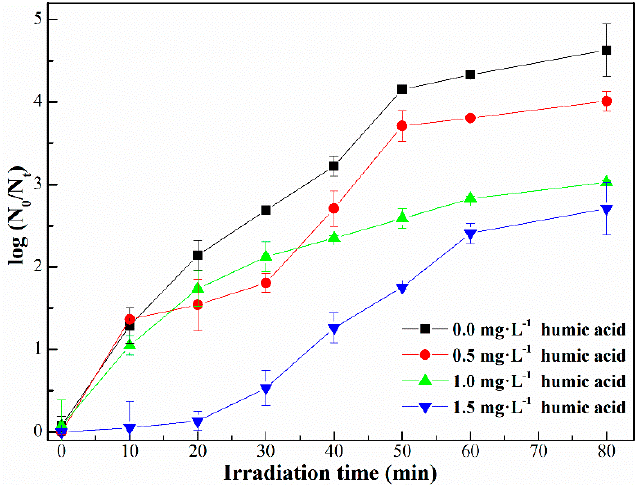
Figure 8. Effect of humic acid on the photocatalytic inactivation towards the bacteriophage f2.